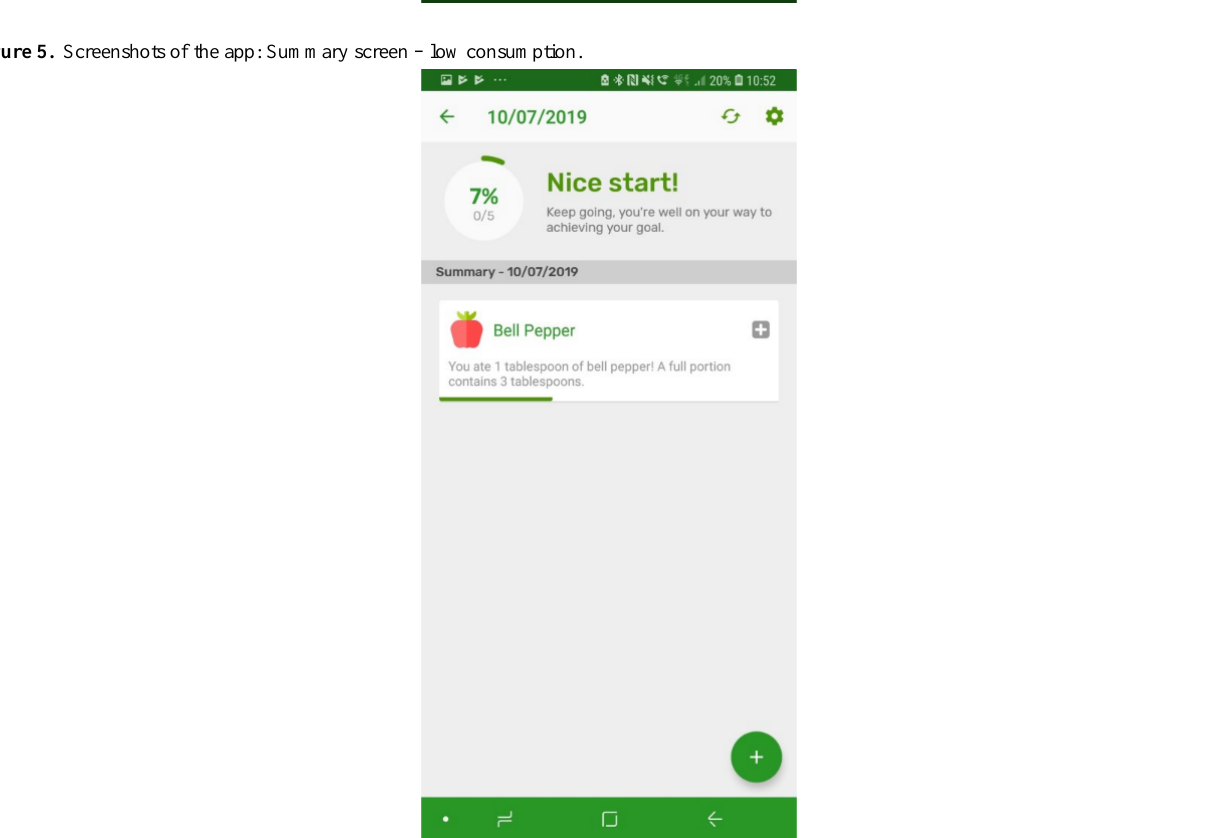
Figure 5. Screenshots of the app: Summary screen – low